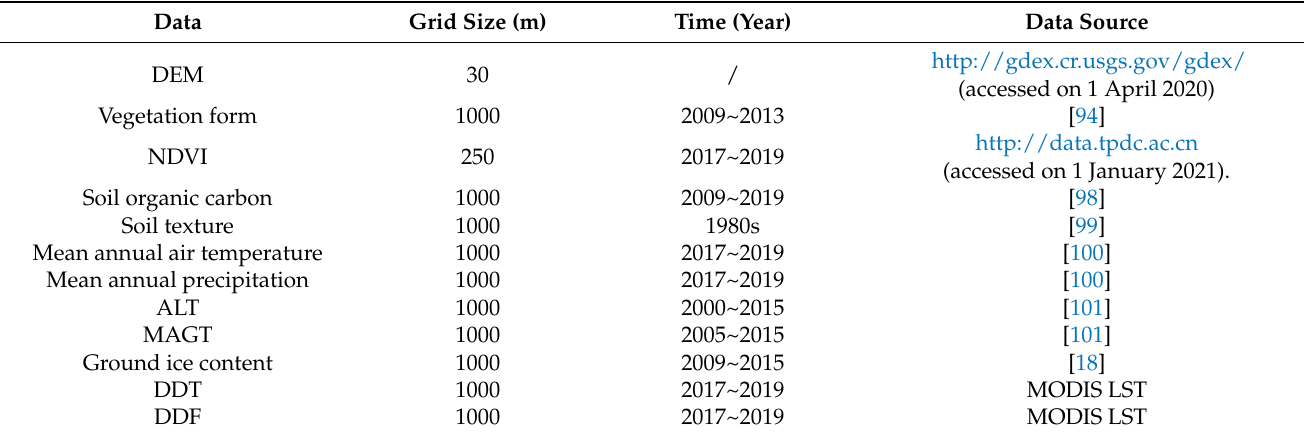
Table 2. Basic information on influencing